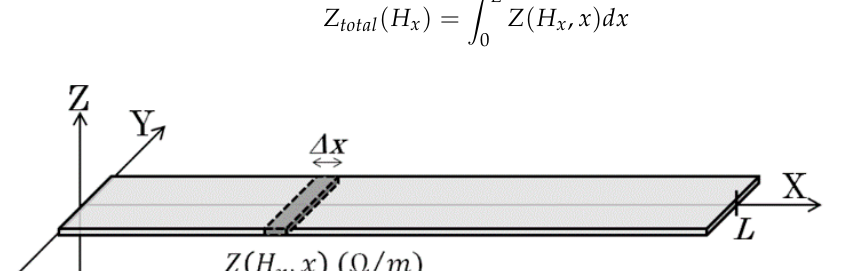
Figure 7. Schematic explanation of magnetization vibration in the thin film magneto-impedance sensor as a function of sensing field in X-direction, when a surface normal field is applied [21]. Based on the assumption mentioned above, the whole impedance of the sensor element is assumed to estimate as an integral of partial impedance of the element as shown in Figure 8. In case of a L mm length sensor, which is placed from x = 0 to x = L , the total impedance is expressed as Equation (4)